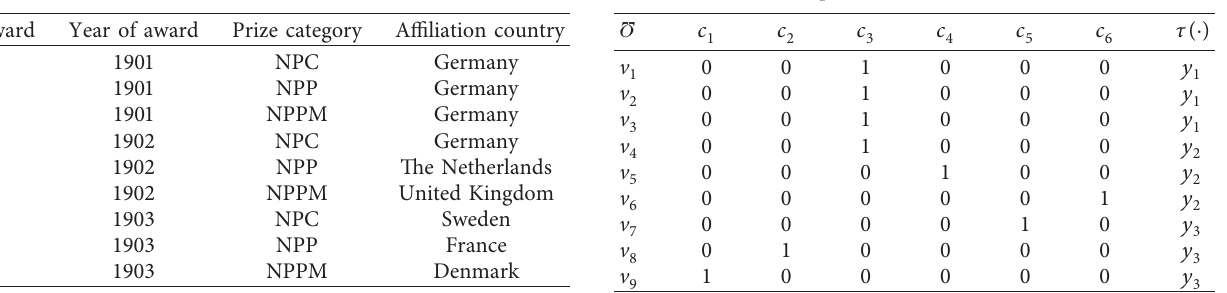
Table 2: Information on NPCs, NPPs, and NPPMs (1901–1903). Table 3: Tabular representation of the TSS T � ( 􏽢 F,C, τ ,Y )